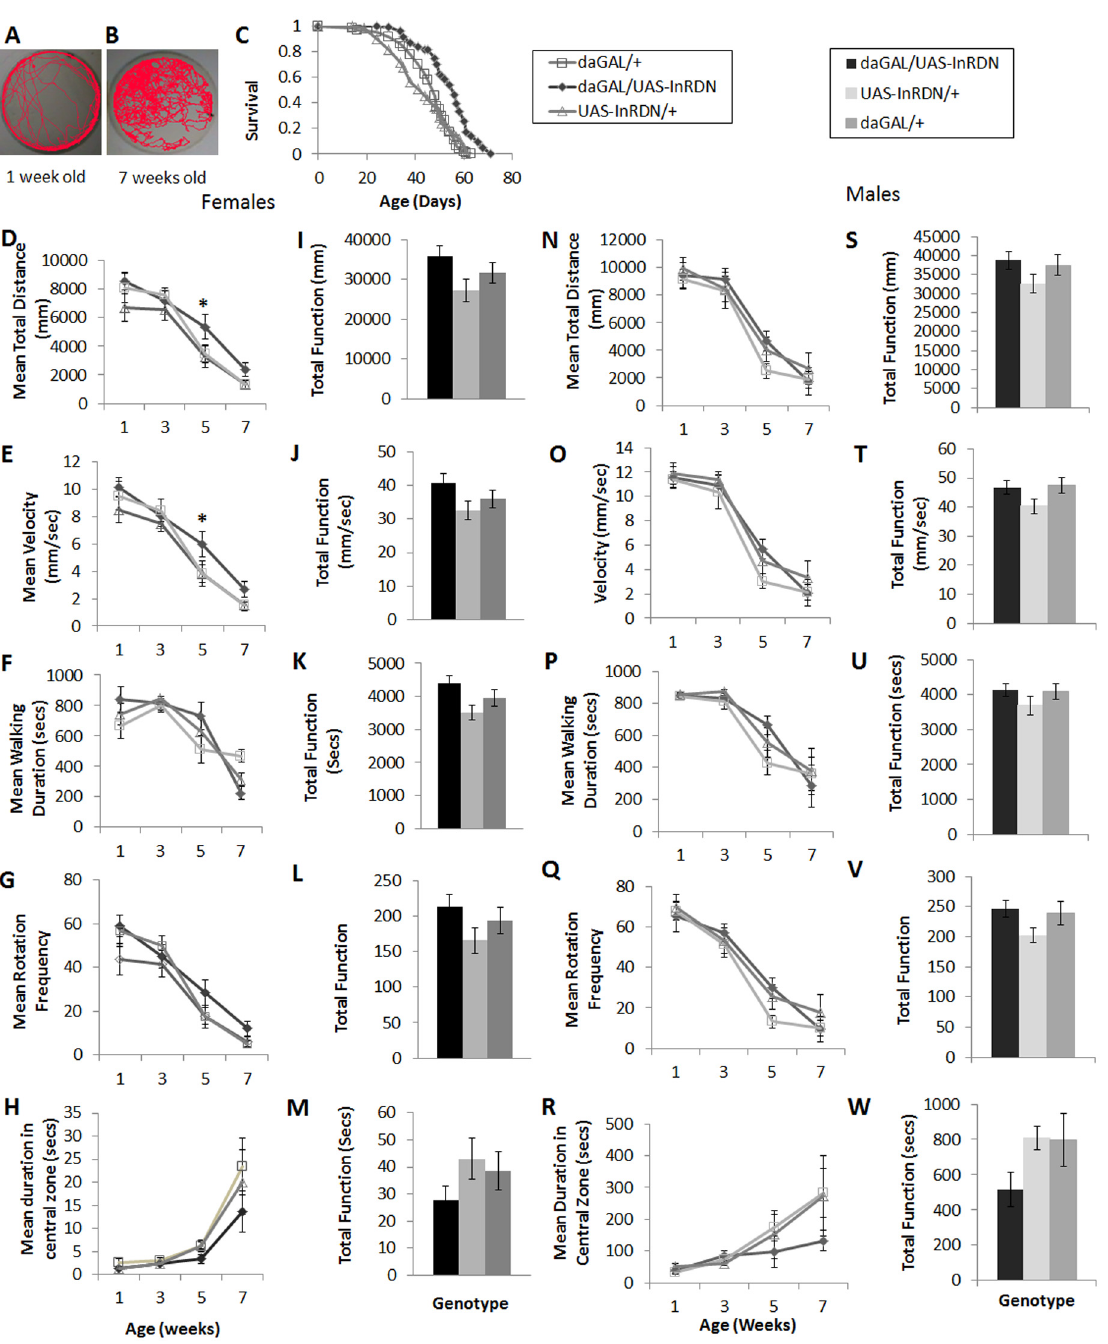
Fig 2. Exploratory walking senescence in daGAL4/UAS-InR DN male and female flies. ( A-B ) Representative images of the exploratory walking track of an individual w Dah control female fly at 1 week old ( A ) and 7 weeks old ( B ) during a 15 minute observation period. ( C ) Survival of daGAL4/UAS-InR DN once mated female flies compared to daGAL4/+ and UAS-InR DN /+ controls. Median lifespans and sample sizes were: daGAL4/UAS-InR DN = 56 days, N = 69; daGAL4/+ = 48 days, N = 99; and UAS-InR DN /+ = 44 days, N = 60. Survival curves were compared using nonparametric log rank tests and p values calculated. daGAL4/UAS-InR DN showed an increased survival compared to both controls (P < 0.0001). ( D-M ) Exploratory walking senescence for a cohort of female flies of the indicated genotypes run in parallel with the survival experiment shown in (C). Data are shown as mean value for each parameter ± SEM, N = 12 for the indicated genotype. ( D ) Female mean distance walked (mm) vs age. ( I ) Female Total Function of mean distance walked (mm). ( E ) Female Mean velocity (mm/sec) vs age. ( J ) Female Total Function of mean velocity (mm/sec). ( F ) Female Mean walking duration (secs) vs age. ( K ) Female Total Function of mean walking duration (secs). ( G ) Female Mean frequency of rotations (change in walking direction) vs age. ( L ) Female Total Function of mean Rotation Frequency. ( H ) Female Mean Duration in Central Zone (secs) vs age. ( M ) Female Total Function of mean duration in central Zone (secs). ( N-W )